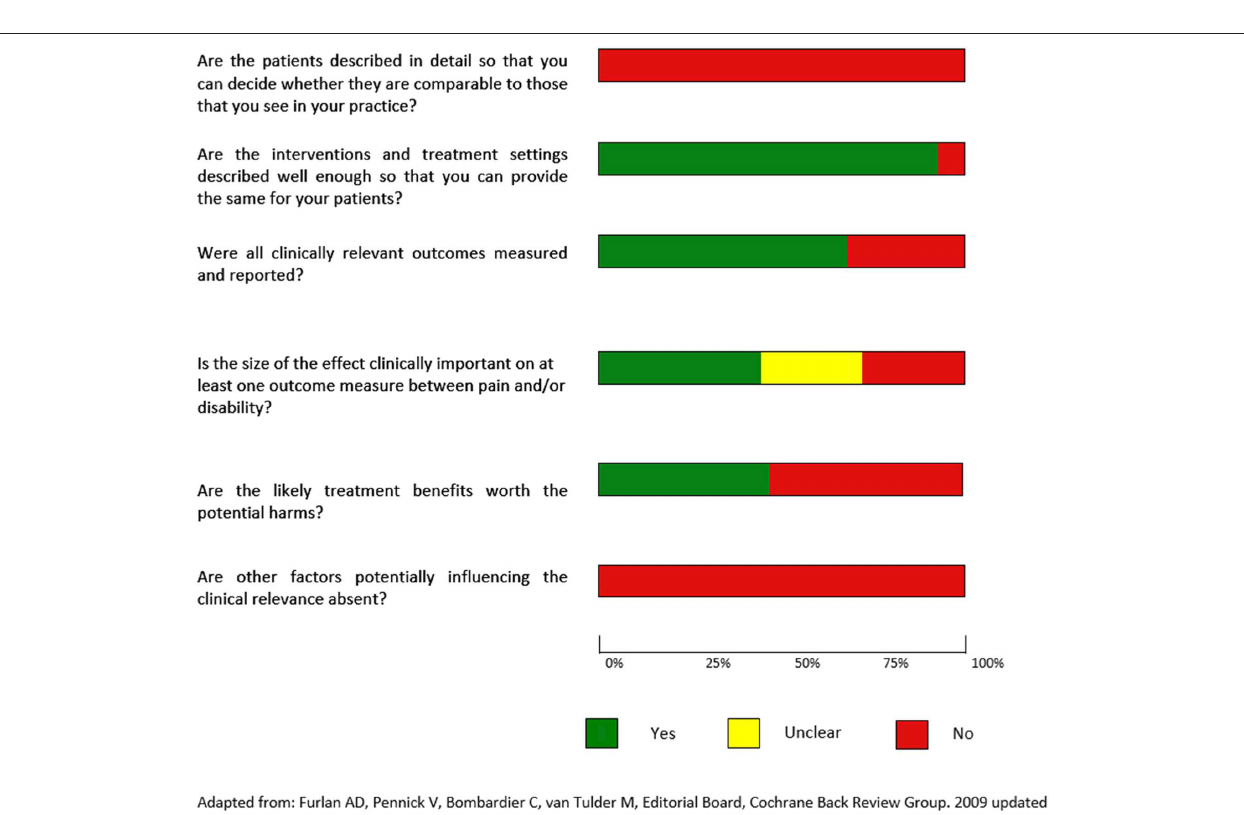
FIGURE 8 | Summary of the evaluation for clinical relevance of included treatment